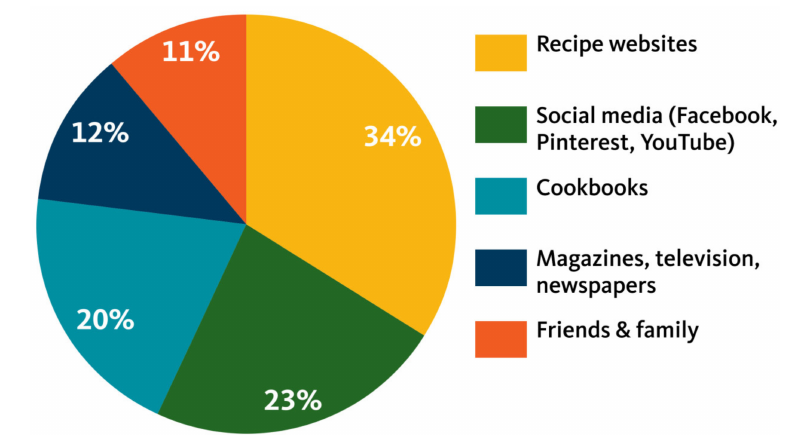
Figure 1. Sources for new recipes.